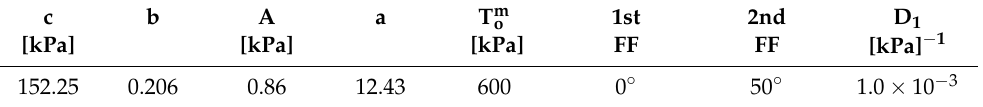
Table 1. Constitutive parameters for the J. Martins constitutive model [29], used on the ERM